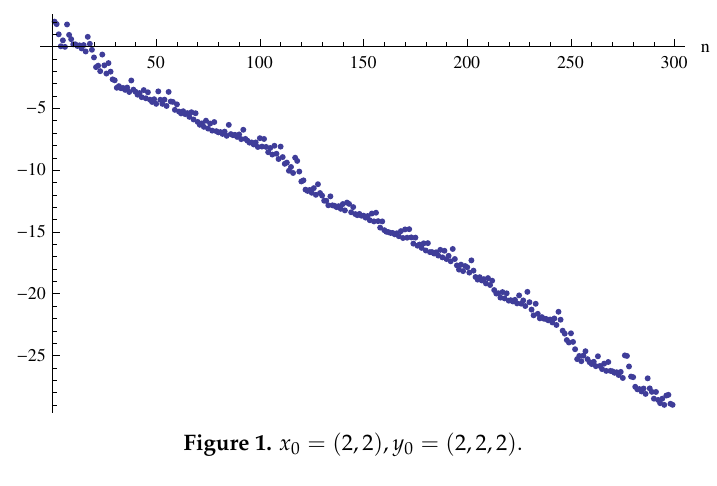
Figure 1. x 0 = ( 2,2 ) , y 0 = ( 2,2,2 ) .